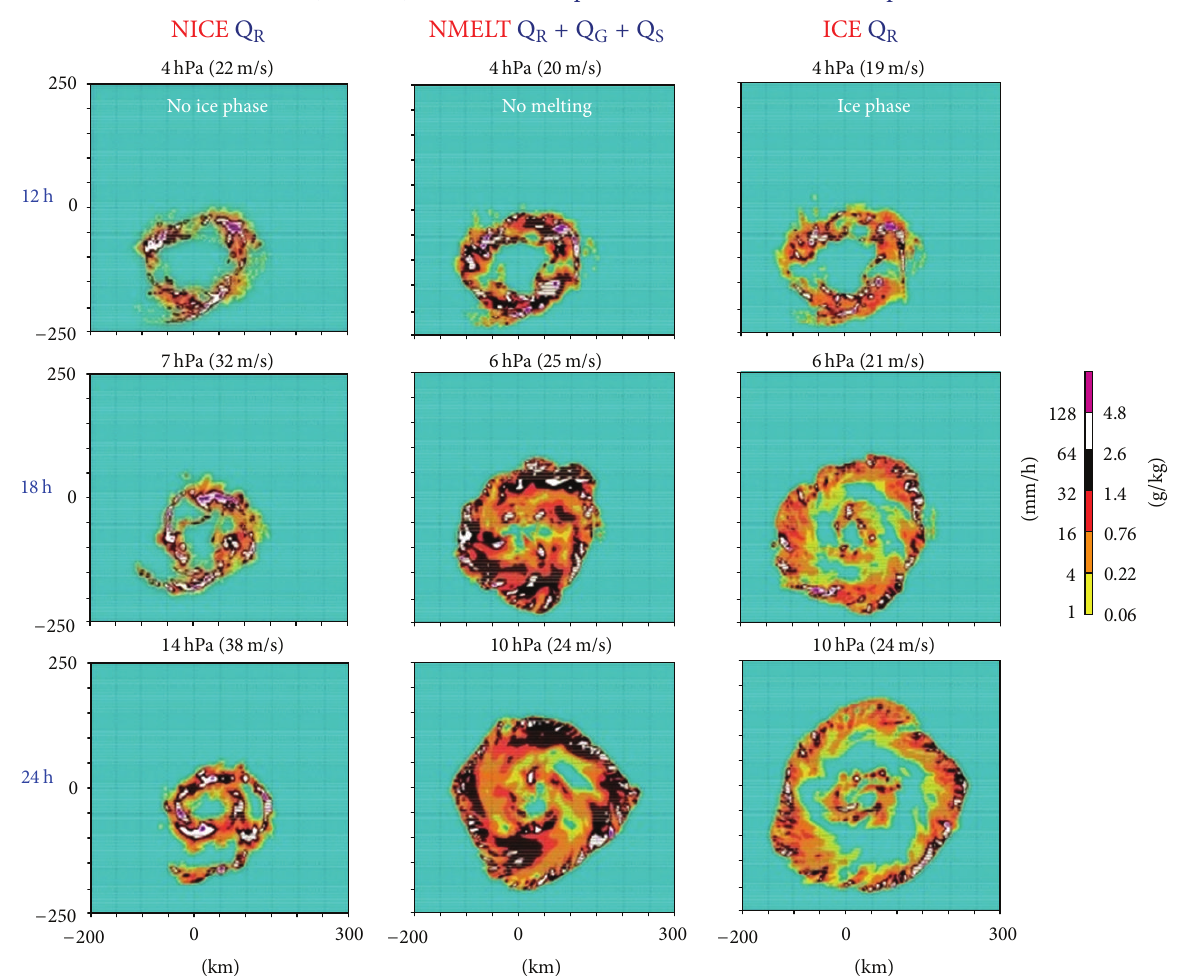
Figure 1: Comparison of the mixing ratio of rainwater at 0.15km height, the central surface pressure and the maximum wind speed at 1.25 km in case NICE, case NMELT, and case ICE at 12h, 18 h, and 24 h. The surface pressure is given by the negative value of its anomaly from the